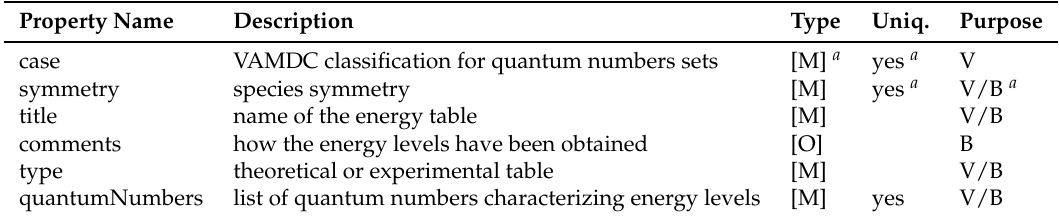
Table 2. List of properties/metadata for the “Energy Table” object. “case” refers to the